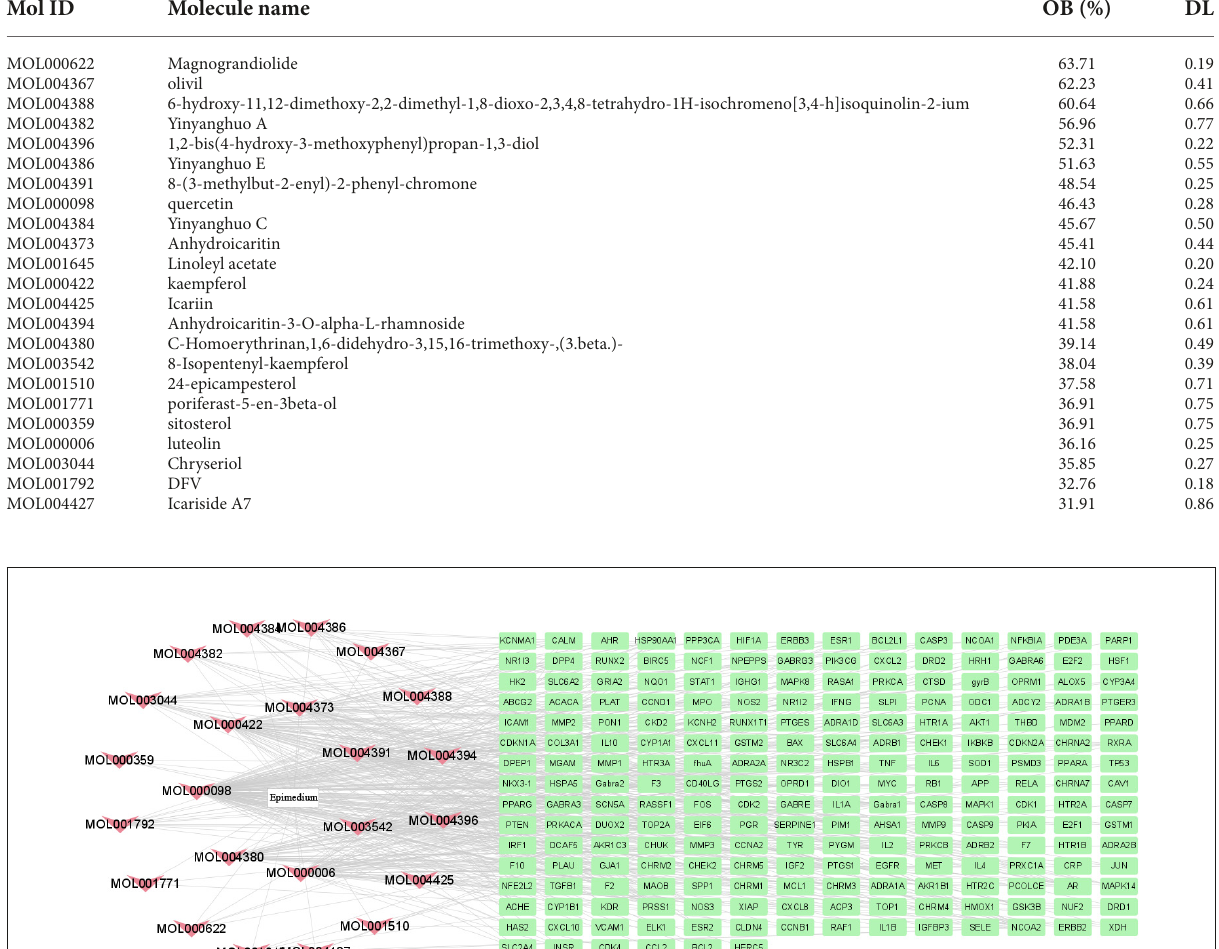
TABLE 2 Bioactive compounds of Epimedium.